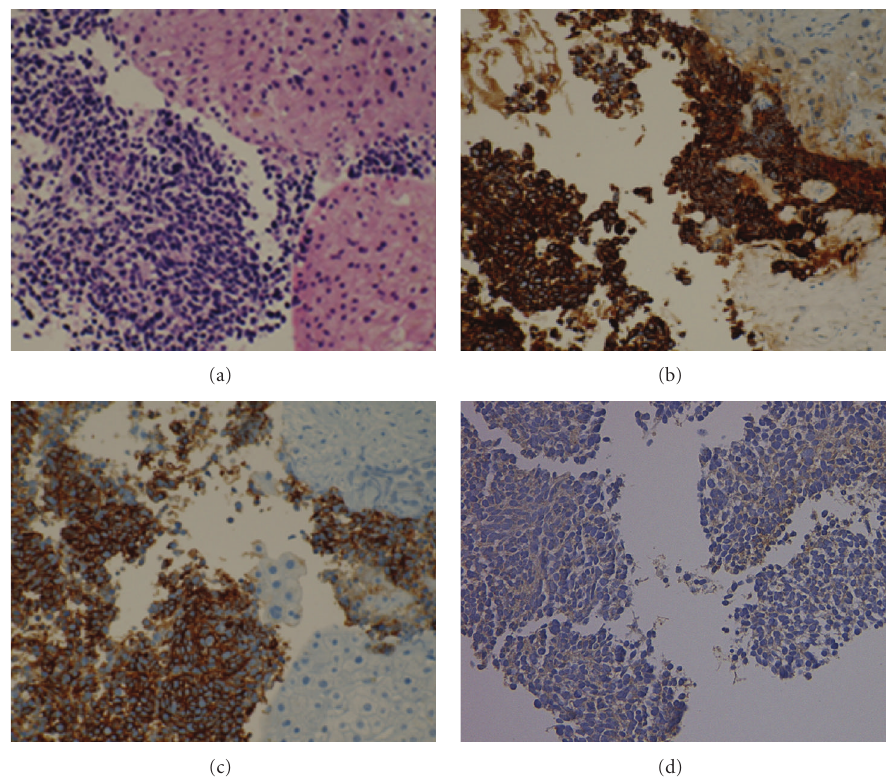
Figure 2: Immunohistochemical examination of small-cell carcinoma of the liver. (a) Tumor cells display large hyperchromatic nuclei and scanty cytoplasm, H&E. (b) Immunohistochemically, the atypical cells are positive for AE1/AE3, (c) N-CAM and (d) NSE. Magnification ratio: 200